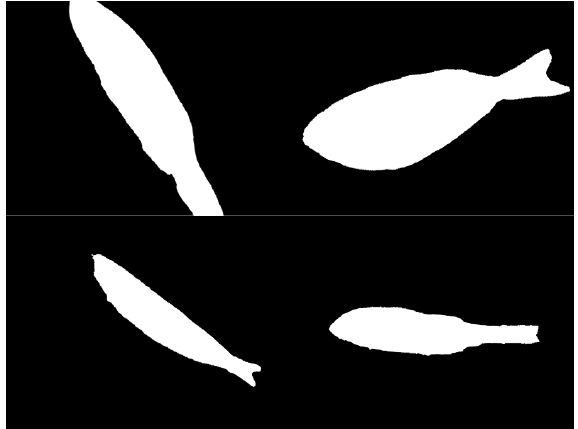
Figure 11. The segmentation results of FCN32s.